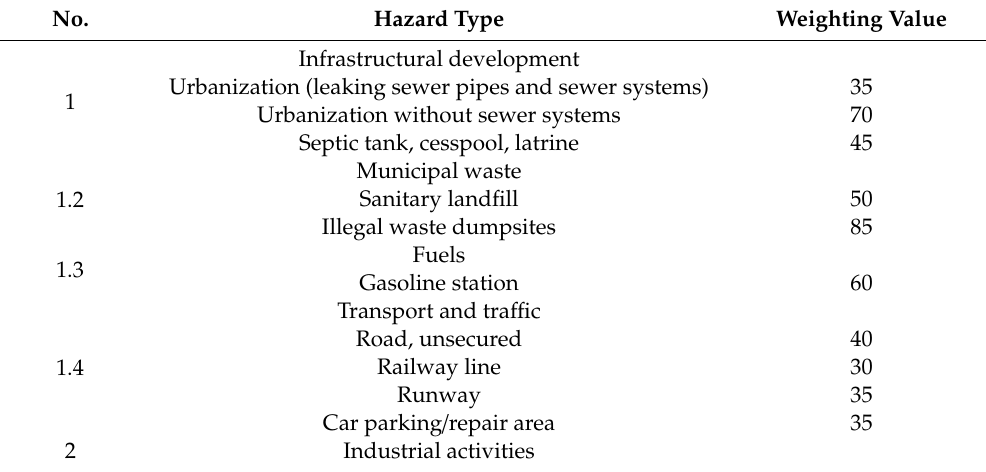
Table 5. Weighting values for hazards identified within the Kupa River catchment area (adapted from [15]).